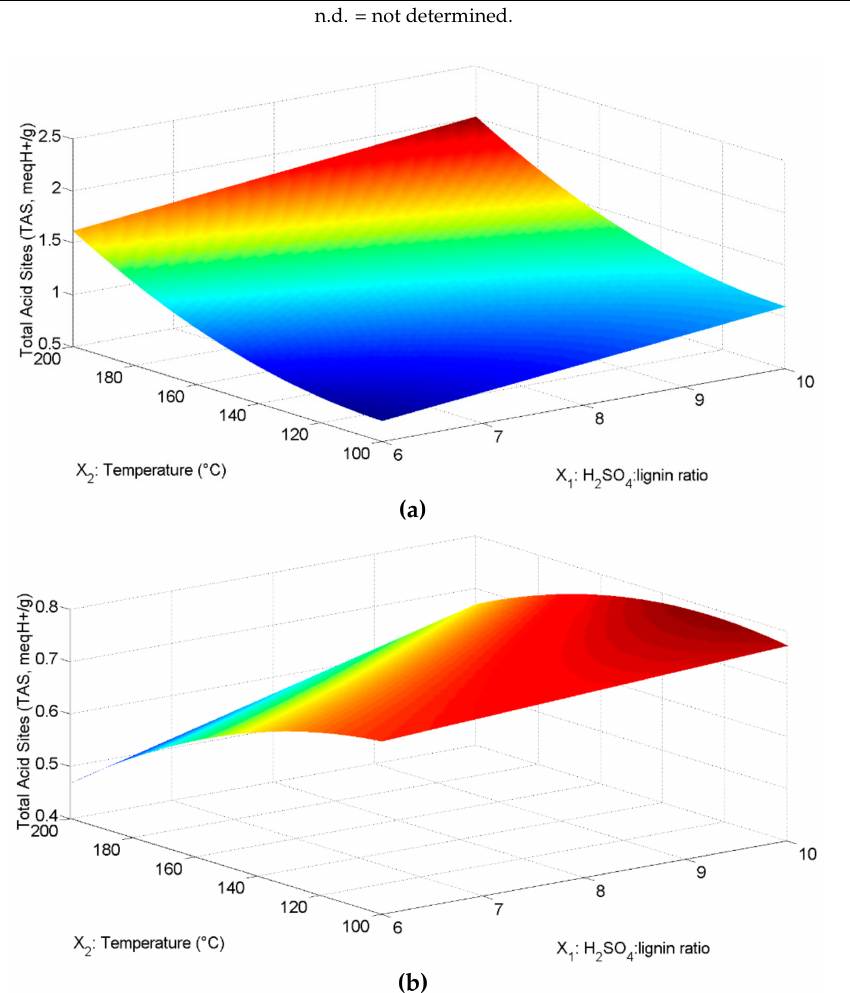
Figure 1. Surface responses for sulfonation experiments. ( a ) Surface response for sulfonation experiments of lignin from pine sawdust (time was set to the optimal value: 1 h); ( b ) Surface response for sulfonation experiments of lignin from processed wheat straw (time was set to the optimal value: 2